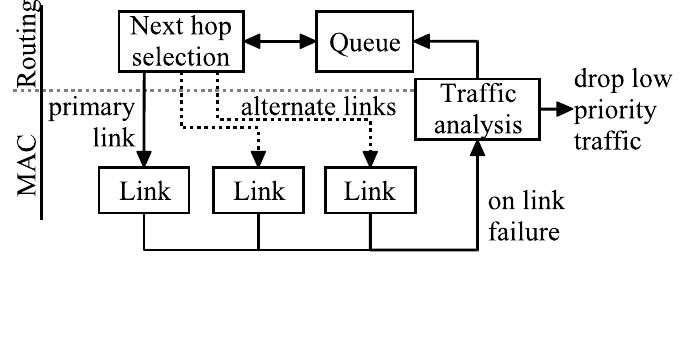
Figure 18. Routing layer end-to-end reliability scheme with intermediate node